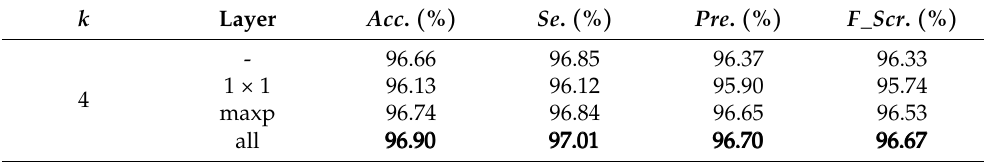
Table 3. Accuracies of 1 × 1 convolutional layer and maximum pooling layer.